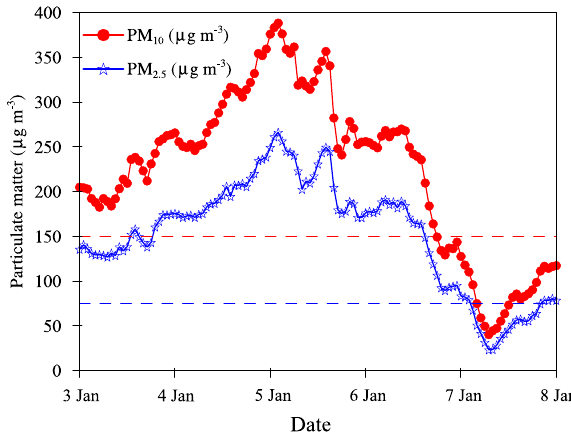
Figure 3. Average hourly concentrations of surface PM 10 (red solid line) and PM 2 . 5 (blue solid line) in the urban agglomeration from 00:00BST on 3 January 2017 to 00:00BST on 8 January 2017 dur- ing event 8. The dashed red line represents the Grade II standard of PM 10 daily concentration (150µgm − 3 ) , and the dashed blue line represents the Grade II standard of PM 2 . 5 daily concentration (75µgm − 3 )